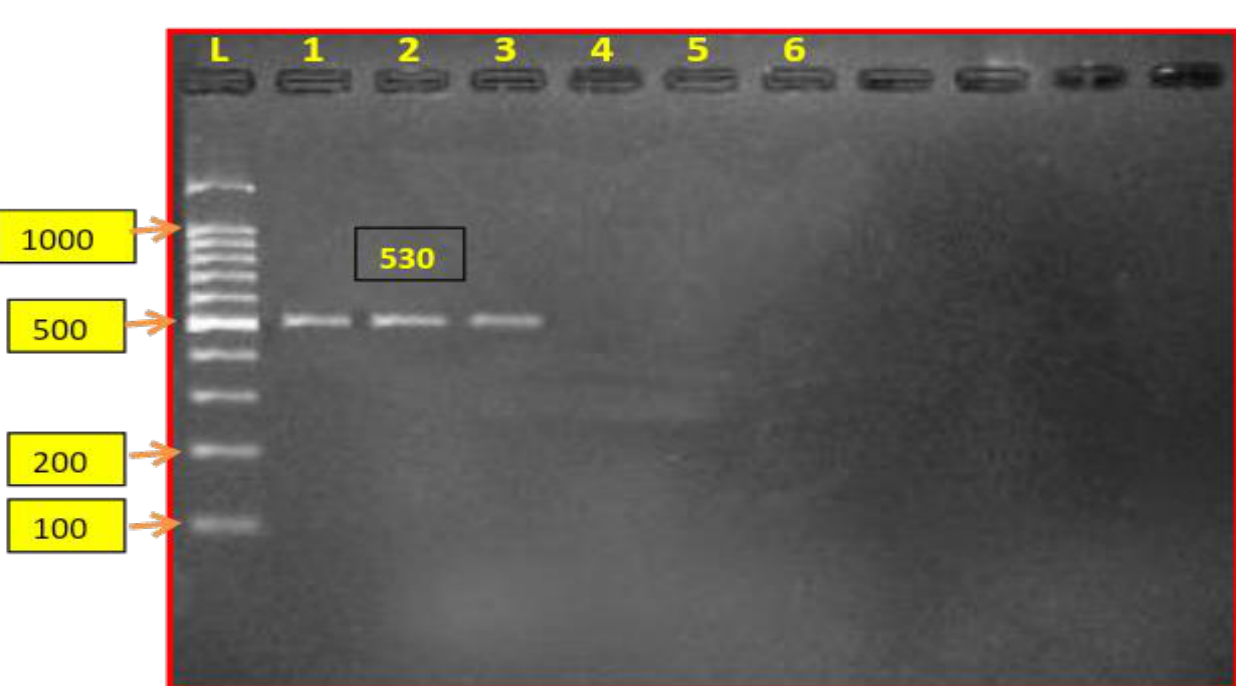
Figure 2. Agarose gel electrophoresis of PCR assay shows the positive aminoglycoside antibiotic resistance genes in some P. aeruginosa isolates. Lane (L) DNA marker (1000-100 bp), Lane (1,2, and 3) positive for AAC-3- Ib gene at 530 bp, Lane (4-6) AAC-3-Ib negative